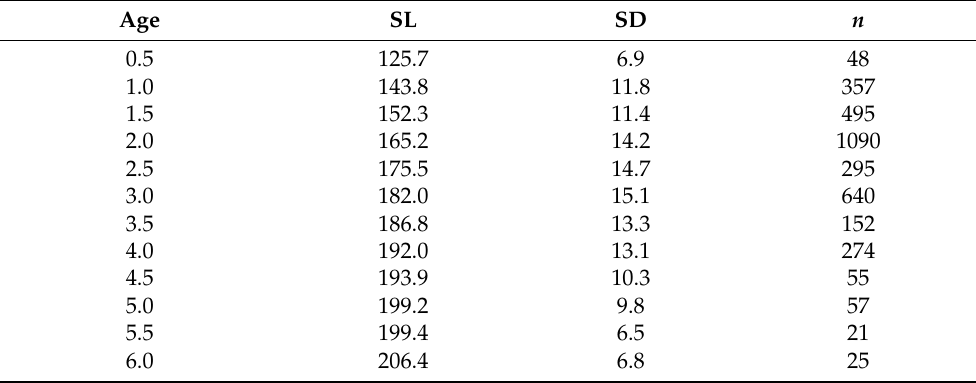
Table 3. Mean standard length (SL, mm) at age and standard deviation (SD) determined for the temperate Sardinops sagax stock in the southern California Current System (CCS) during the study period (2005–2014) ( n : sampling size).